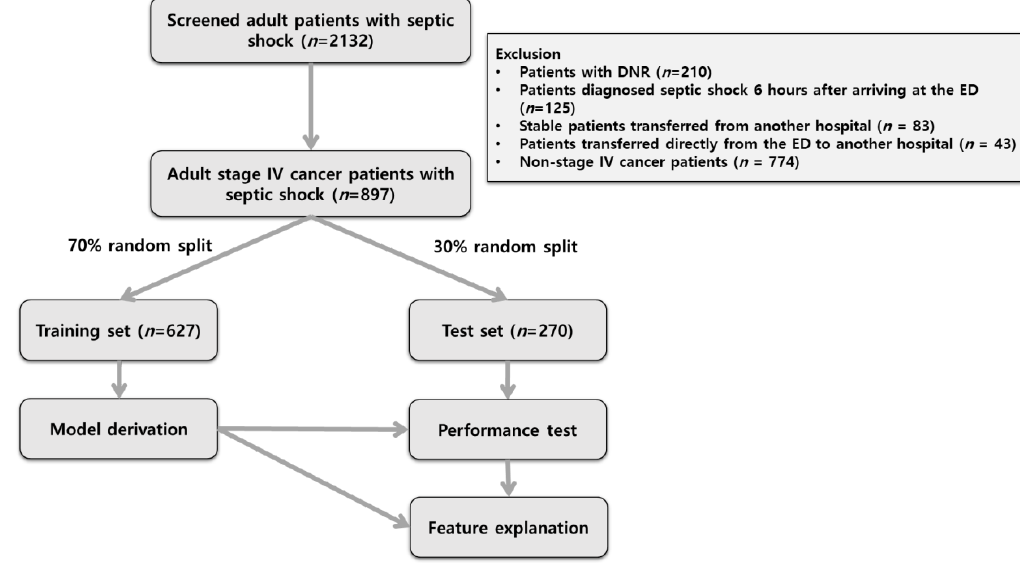
Figure 1. Patient selection flow diagram. DNR, do not resuscitate; ED, emergency department. Table 1. Comparison of characteristics of survivors and non-survivors between October 2016 and